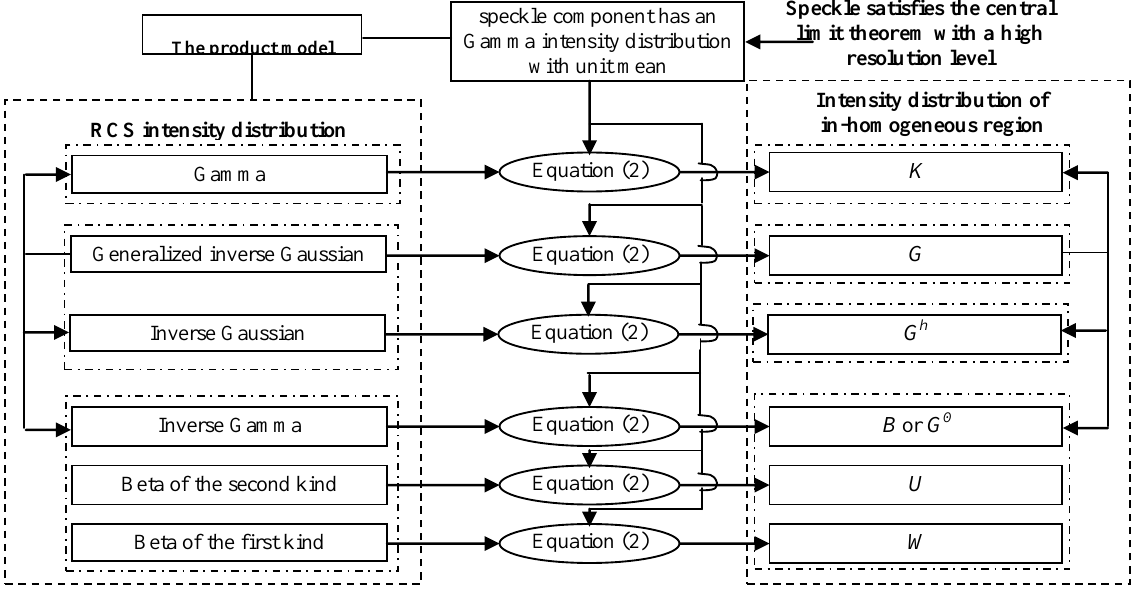
Figure 5. Statistical models of RCS fluctuations when the speckle component satisfies the central limit